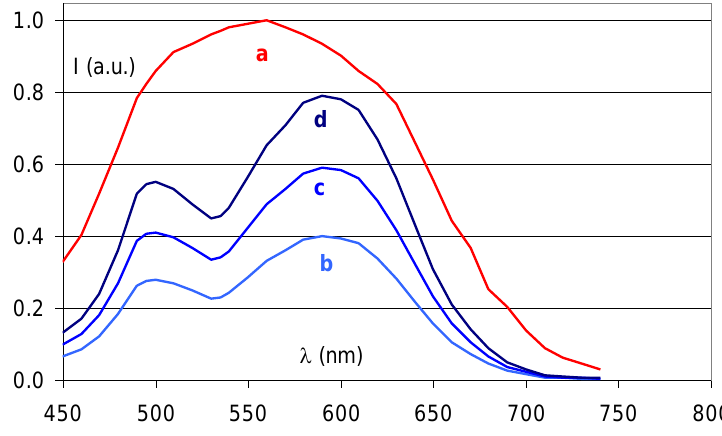
15. Stimulation spectrum measured at 300 K after X-ray exposure